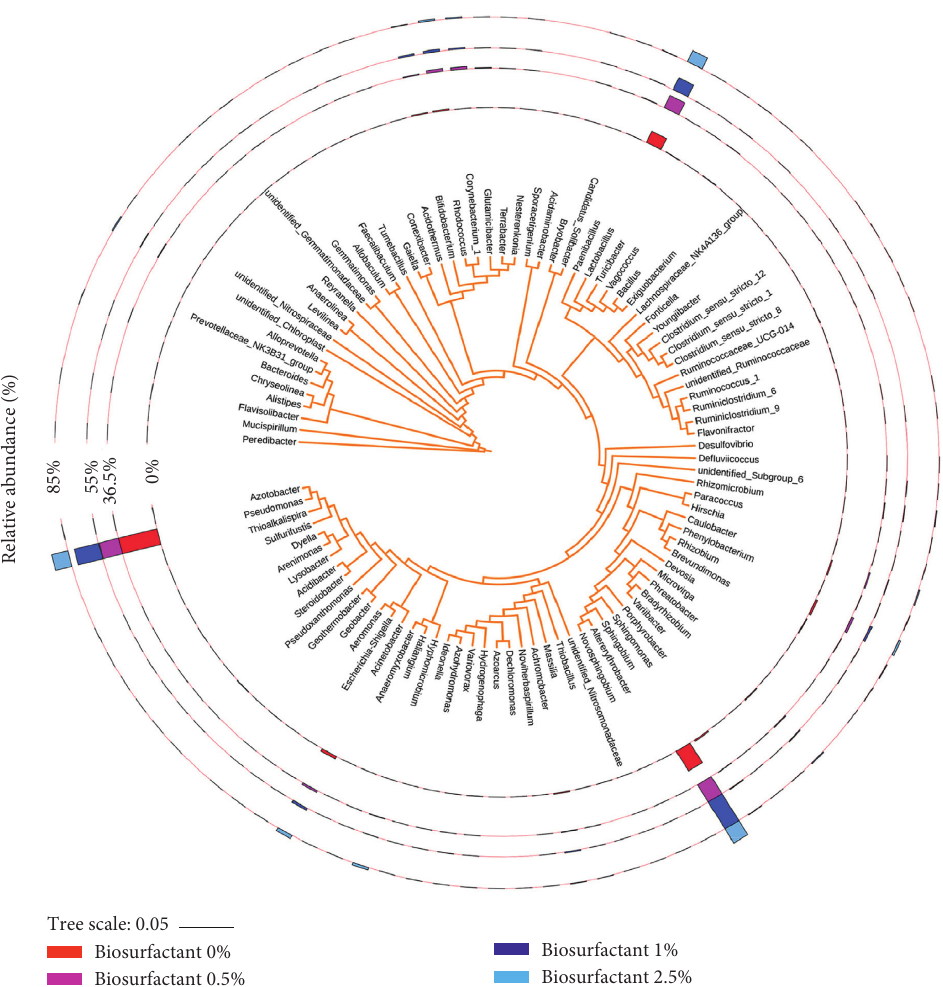
Figure 5: Circular maximum likelihood phylogenetic tree at the level of genus. The consecutive circles from the center to the periphery represent mortars with biosurfactant concentrations of 0%, 0.5%, 1%, and 2.5%, respectively. The outer bands show the relative abundance of the top 100 bacterial genera found in the mortar